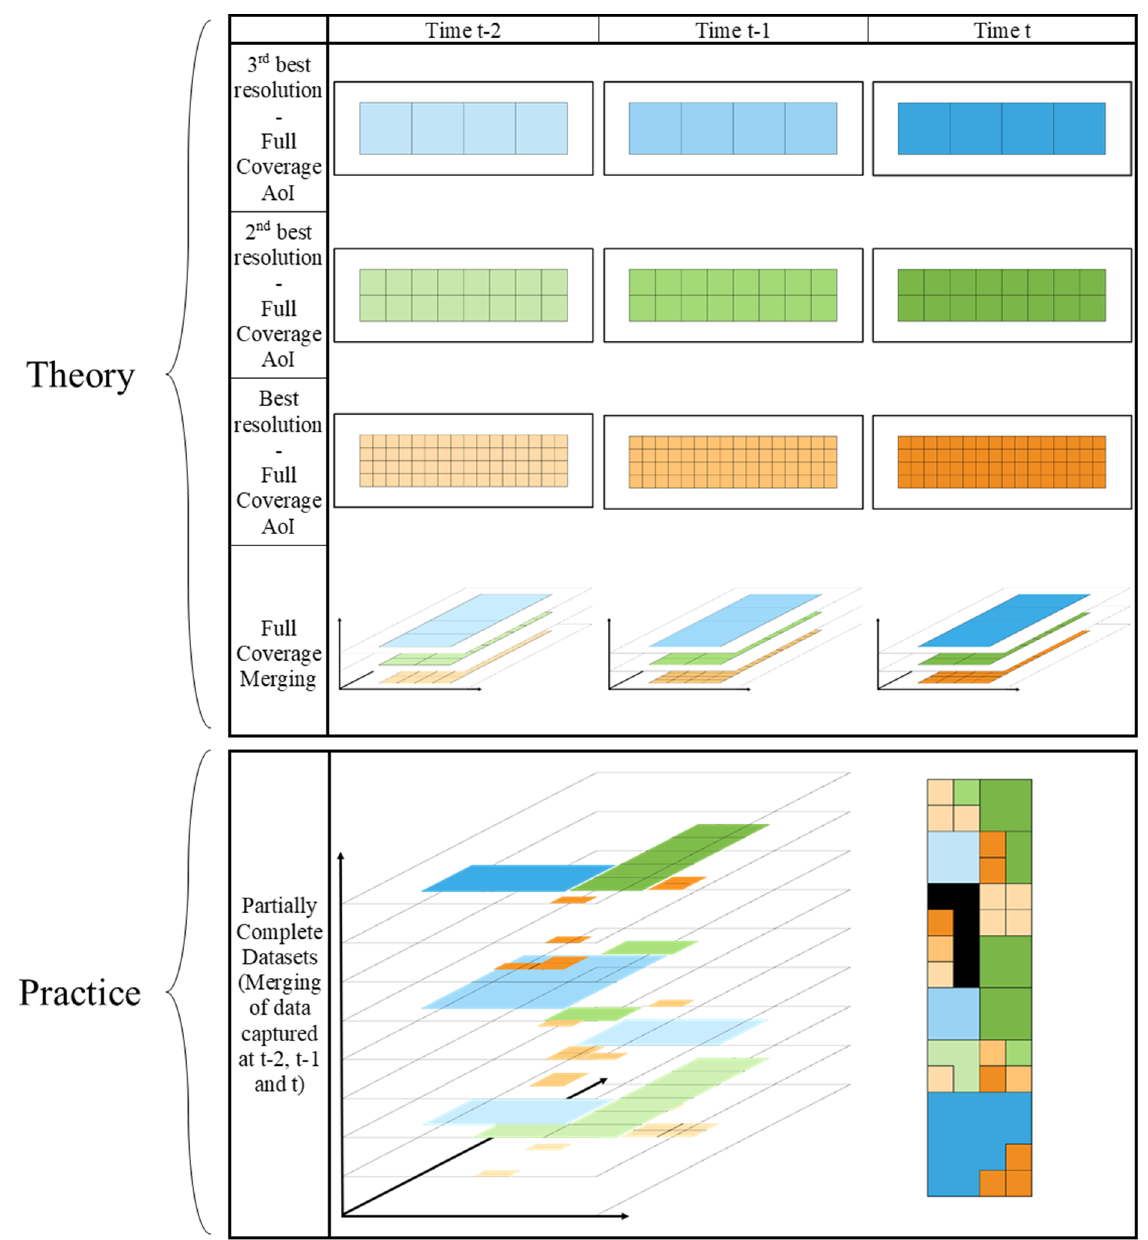
Figure 5. Differences between theory and practice in the spatiotemporal characterization of a generic parameter in a predefined area of interest ( AoI ). Incomplete datasets encountered in practice lead to the dilemma of sometimes having to choose between resolution and timeliness to inform the chosen parameter. Additionally, some regions may show total absence of information (black region in merged 2D view of the AoI at the bottom right of the image), which is particularly problematic for a risk assessment to be executed in that area.